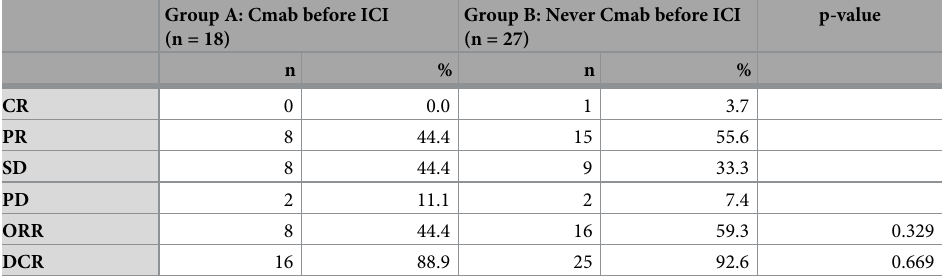
Table 3. Best response of SCT (paclitaxel and cetuximab).